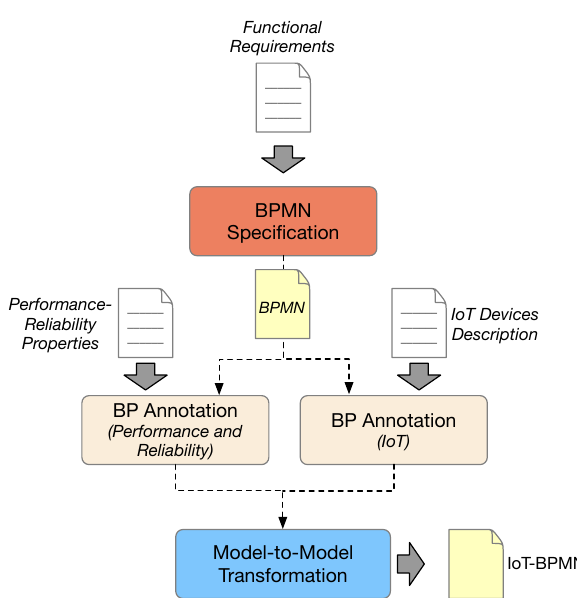
Figure 8. Methodology for the IoT-aware BPM.